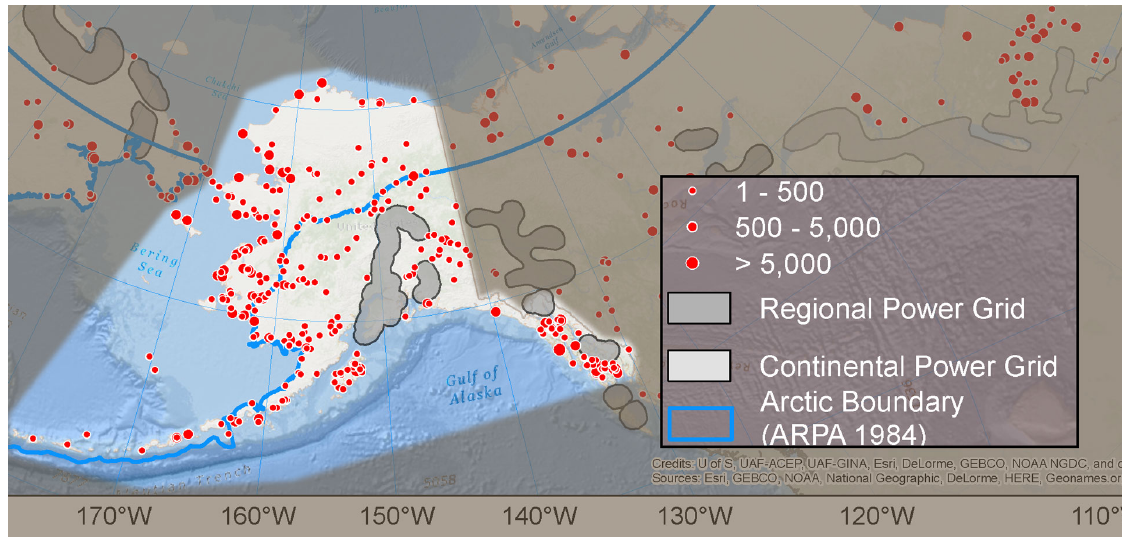
Figure 2. Pan-arctic circumpolar off-grid settlements